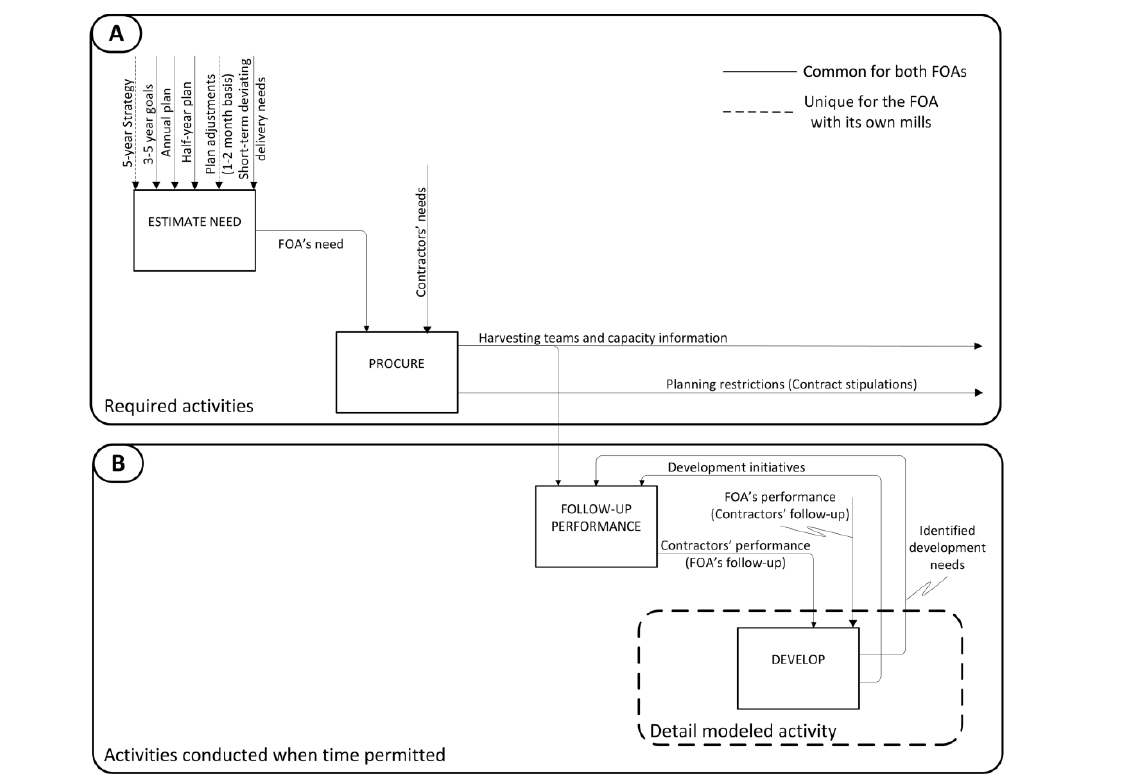
Figure 9. Sub-activities in the Adapt harvesting fleet activity. Inset A marks activities that were required in operational management. Inset B marks activities that were only conducted when time was available. The dashed arrows indicate controls that occurred only in the FOA with its own mills. The dashed inset on the lower right of inset B marks the activity modeled in further